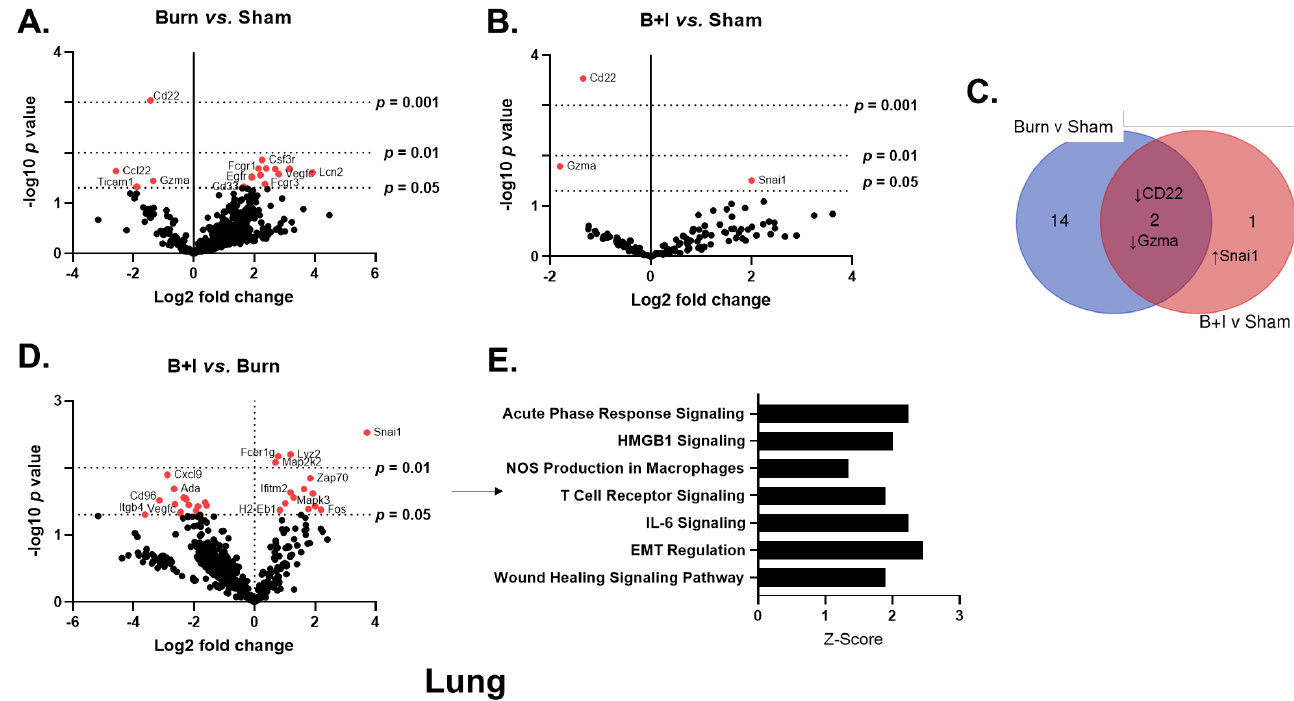
Figure 4. Injury type induces differential pulmonary gene expression and associated canonical pathway activity. Mice underwent sham, burn, or combined B+I injury, and were sacrificed at 24 h post-injury (n = 6 per group). mRNA was extracted from whole lung tissue and NanoString analysis performed with a mouse Cancer Immune Panel, allowing expression analysis of 770 immune and metabolic genes. ( A – C ) are volcano plots of injury-induced differential gene expression, where red dots signify p < 0.05 ( − log10( p -value) > 1.301). A Venn diagram was constructed ( C ) to summarize the number and identity of genes that are impacted in a unique or common fashion to each injury type (when quantified vs. sham). Differential gene expression and pathway Z-scores between B+I and burn alone were analyzed via Ingenuity Pathway Analysis ( D , E ); only significantly altered ( p < 0.5) pathways are